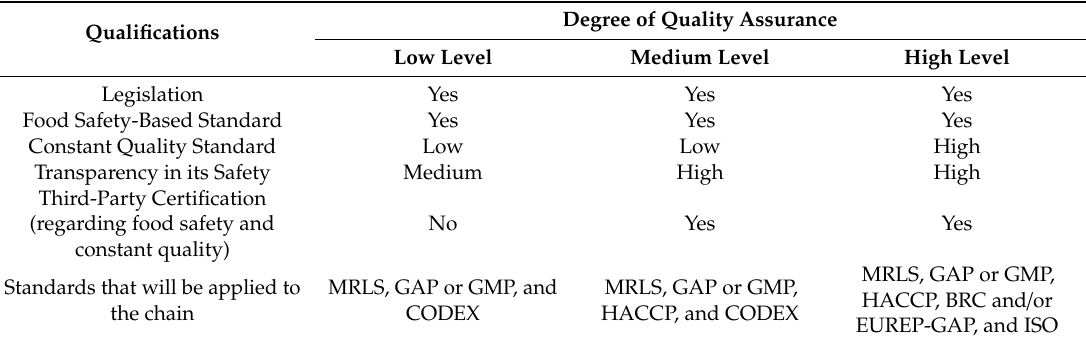
Table 2. Axis 1: degree of quality assurance in three levels.